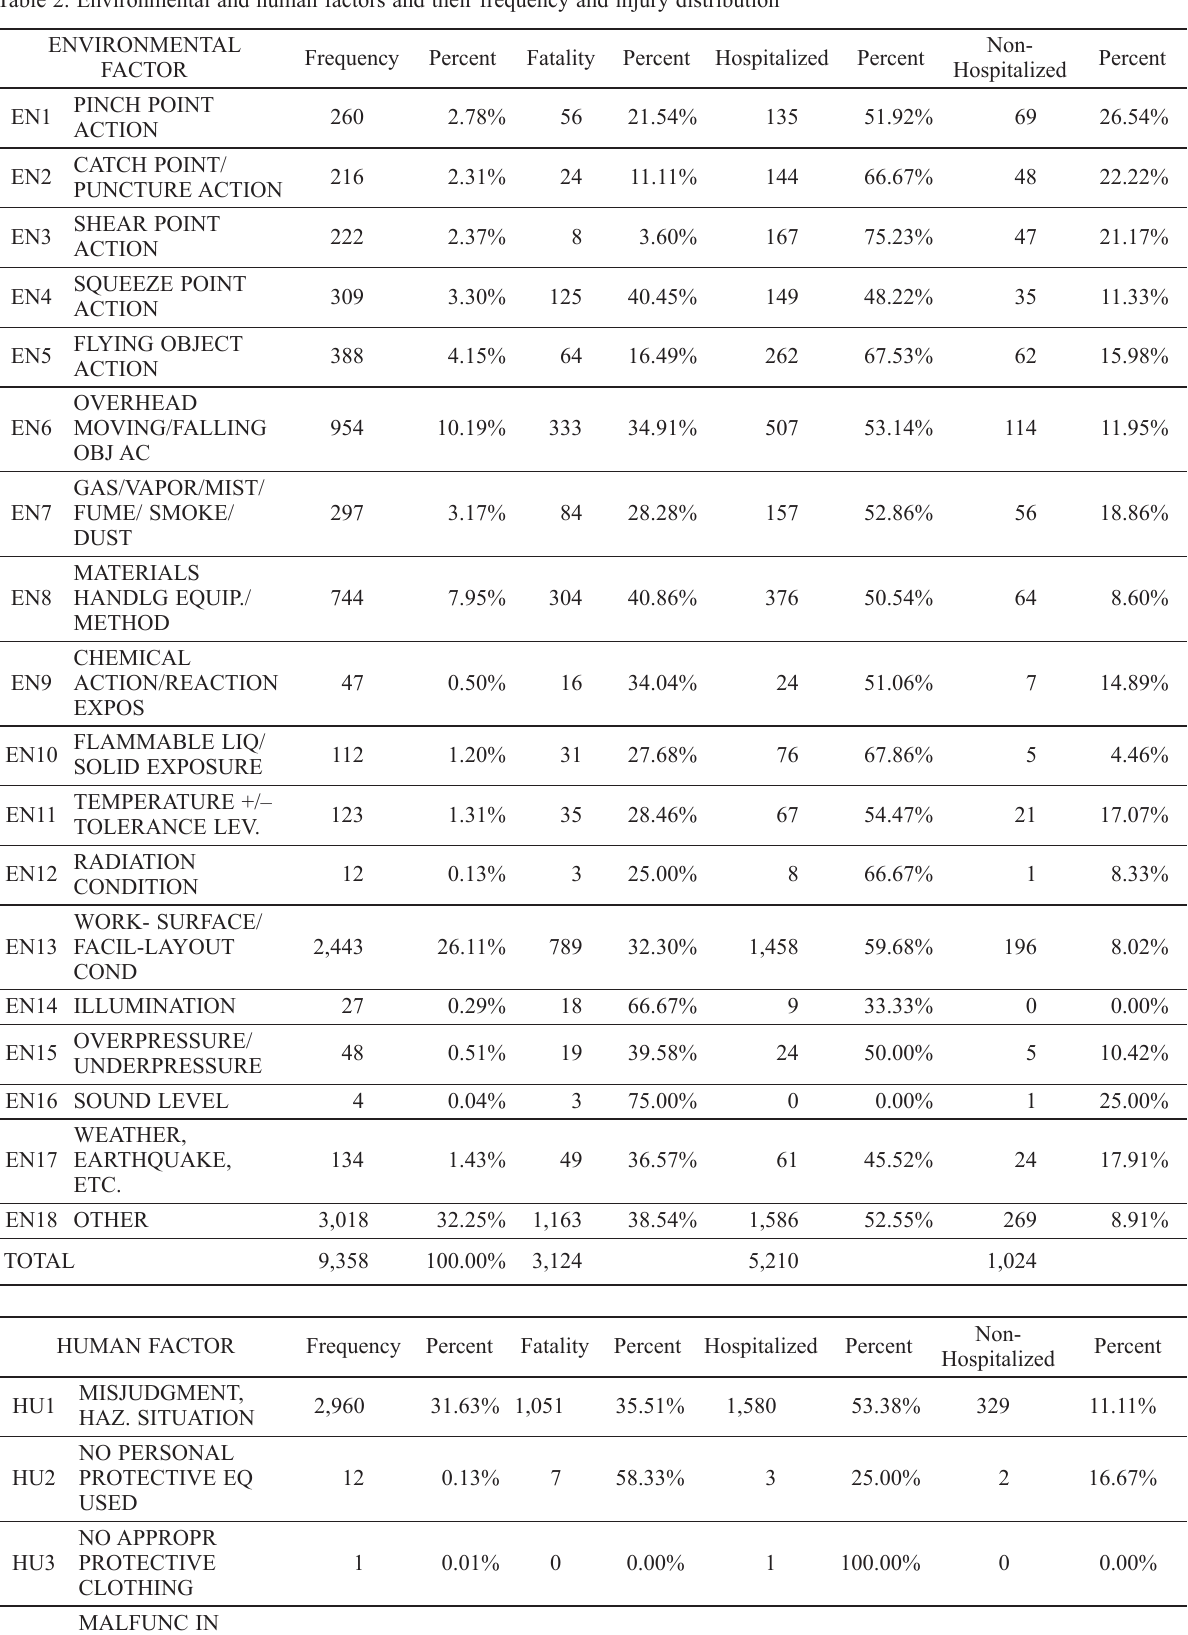
Table 2. Environmental and human factors and their frequency and injury distribution ENVIRONMENTAL